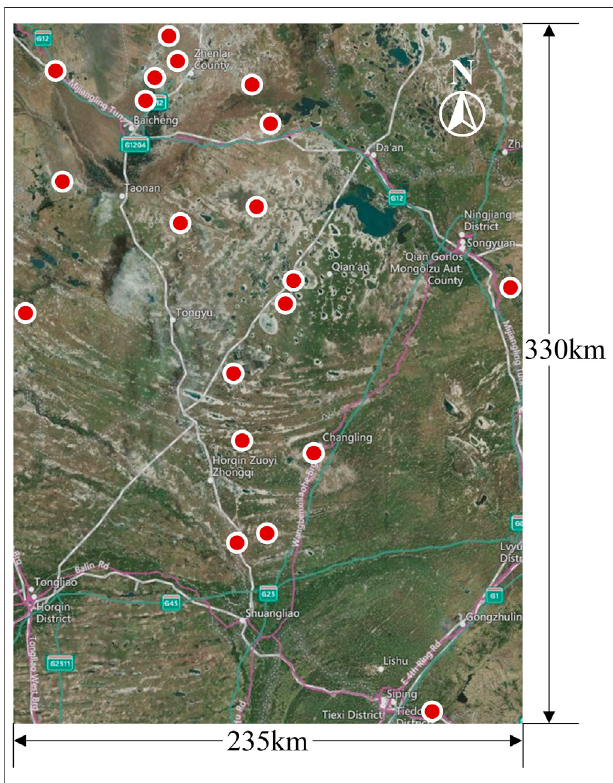
FIGURE 7 | Geographic location map of the wind farm cluster.